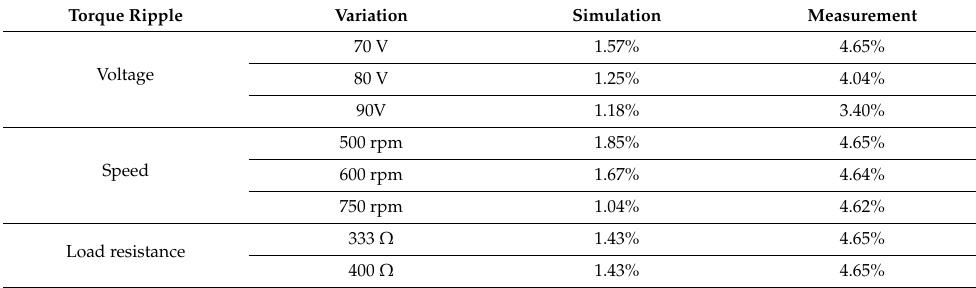
Table 1. Voltage ripple comparison between measurement and simulation